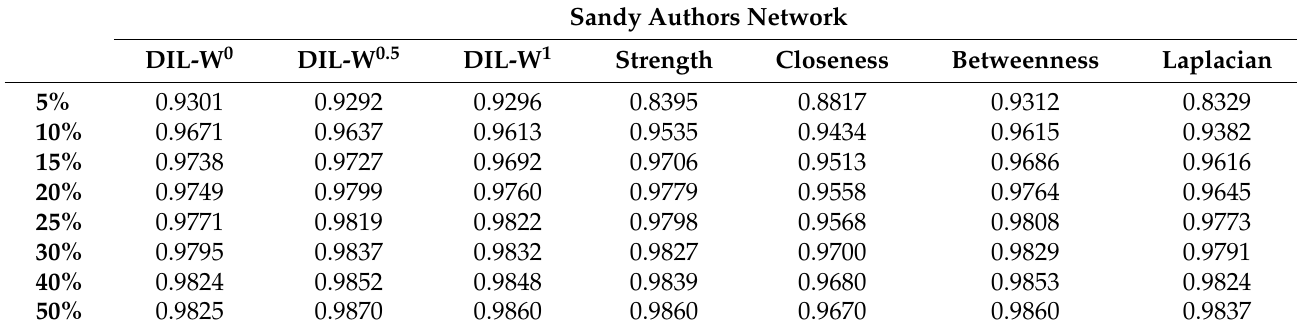
Table A3. σ according to different values of k in Sandy authors Network.